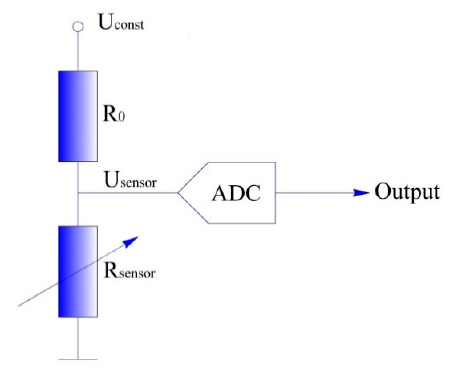
Figure 8. The schematic diagram of the contact force detection circuit.